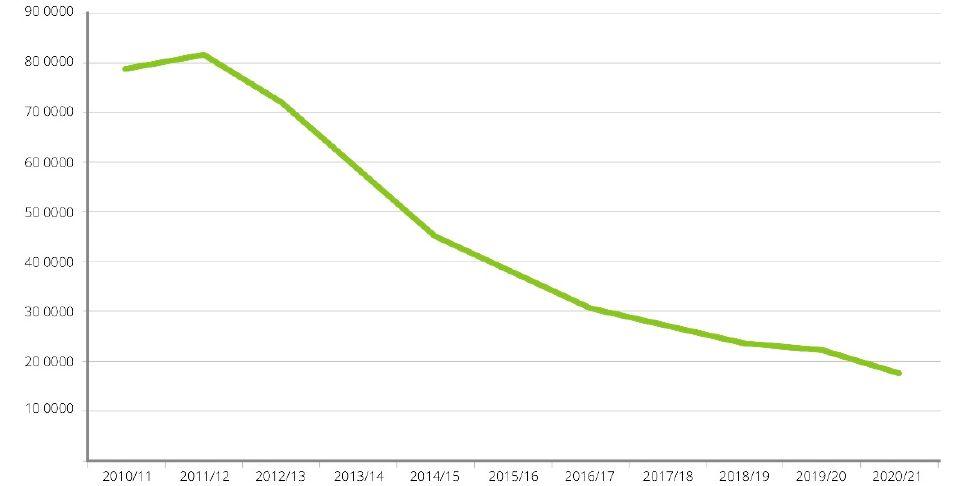
Figure 2. Persons setting a quit date using NHS stop smoking services 2010/11 to 2020/21.